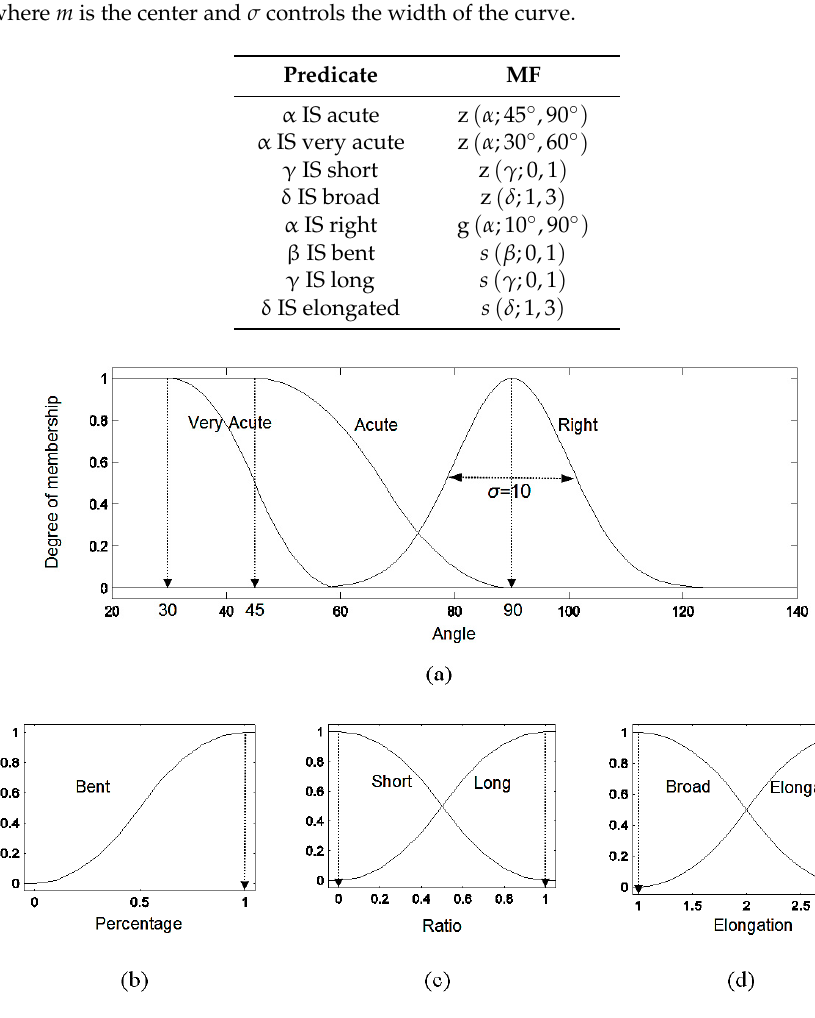
Figure 6. MFs. ( a ) shows MFs for very acute, acute and right angle, input is the junction angle α ; ( b ) shows the MF for bent tributaries, the input is bent tributaries percentage β ; ( c ) shows the MF for a short tributary, input is average length ratio γ ; ( d ) shows the MF for elongated catchment, input is catchment elongation δ